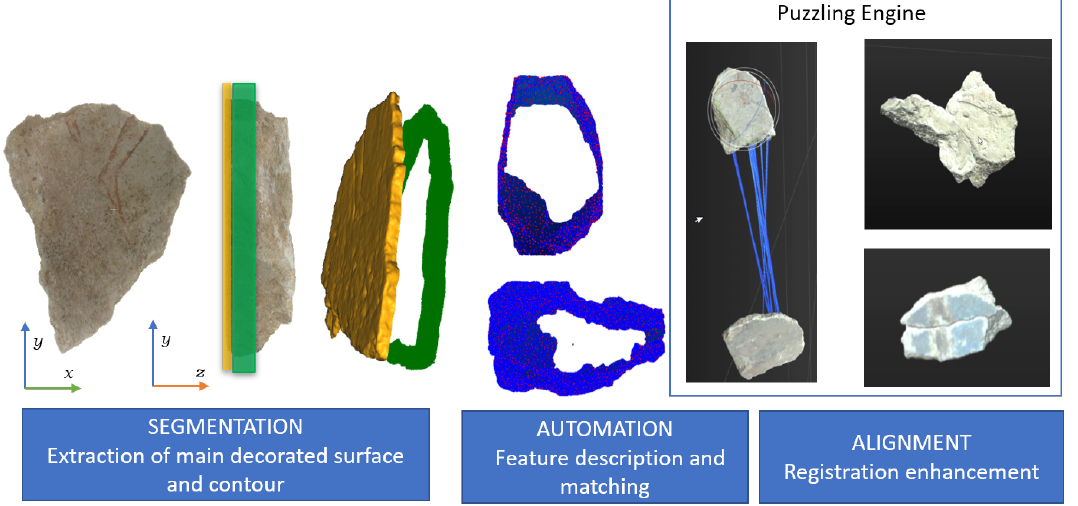
Figure 1. Overview of the proposed registration pipeline for pairwise puzzling. The Segmentation stage aims at extracting both the main decorated surface and contour of wall decorated fragments. These regions of interest are processed in the Automation stage, which consists of a feature-based registration pipeline to propose alignment solutions. The final stage is the virtual interface that allows the user to finely align matching points between counterpart